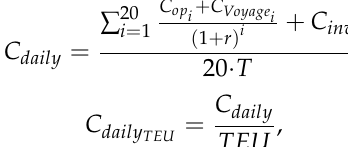
Figure 5. Fuel pricing scenarios.